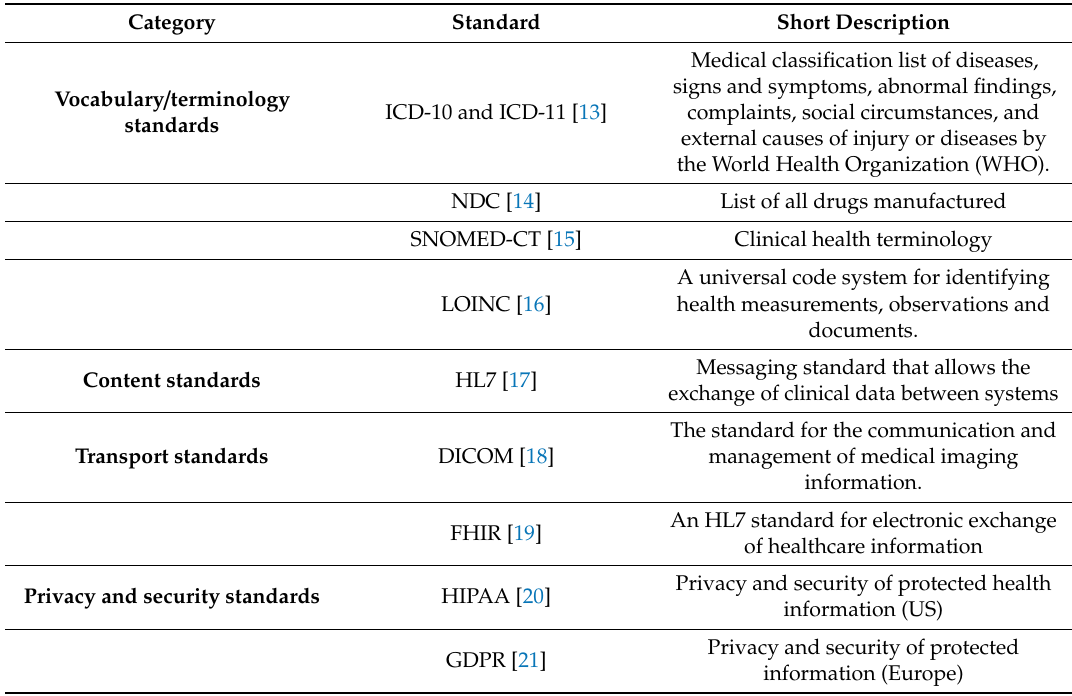
Table 1. Overview of the interoperability standards in